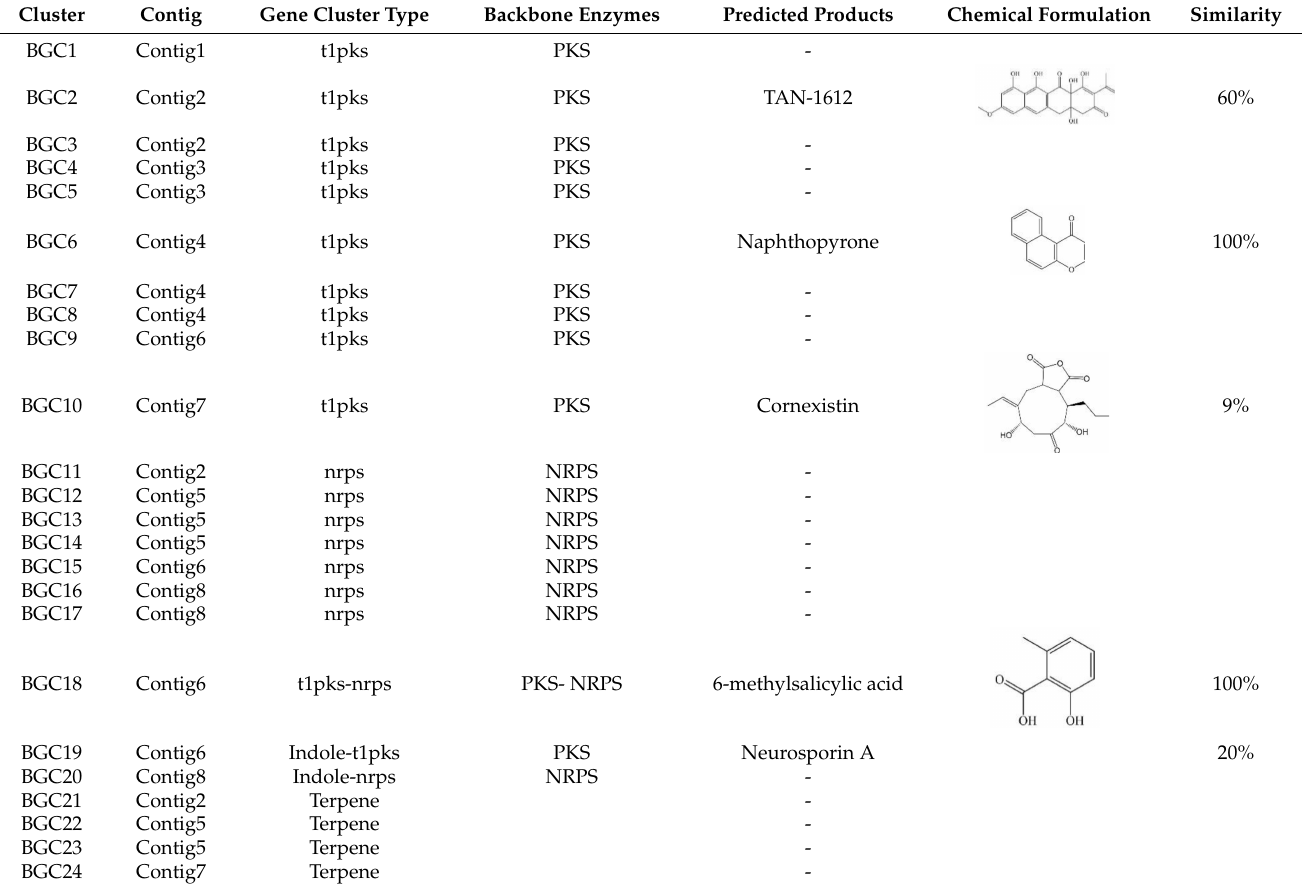
Table 2. Secondary metabolites gene clusters in Eurotium cristatum